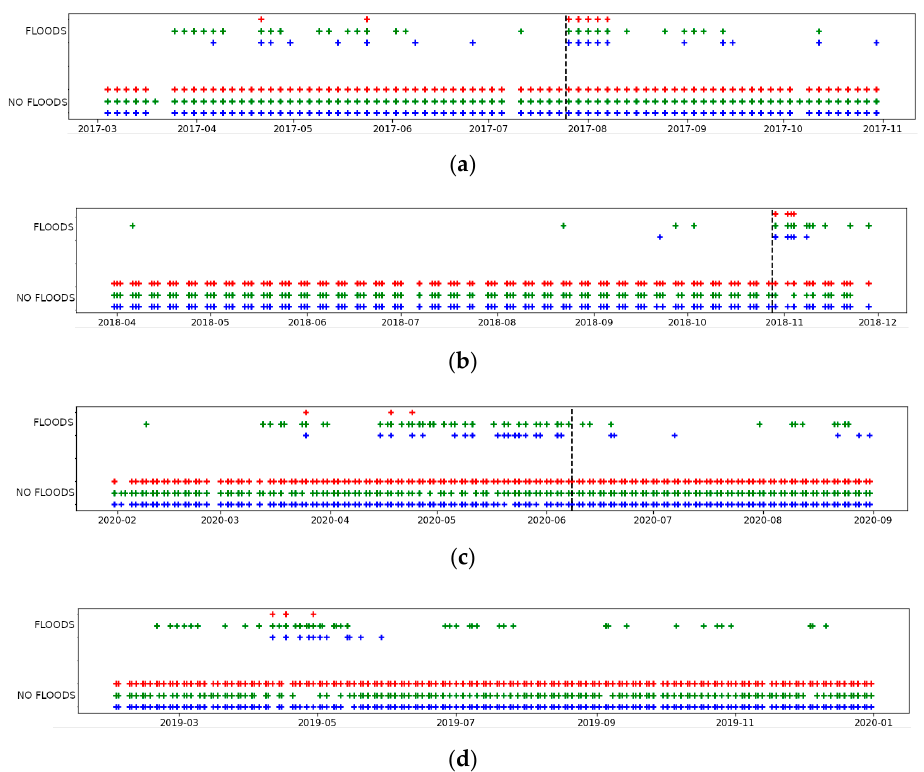
Figure 19. Frequency of false positives for various processed localities: ( a ) Germany, ( b ) Austria, ( c ) central Moravia, ( d ) south Moravia. The black dashed line indicates the date of the start of the real flood event (no floods in south Moravia). Blue crosses represent VV polarization; green crosses represent VH polarization; red crosses represent their combination (final result). The crosses are plotted for all processed tracks and all processed sub-areas.